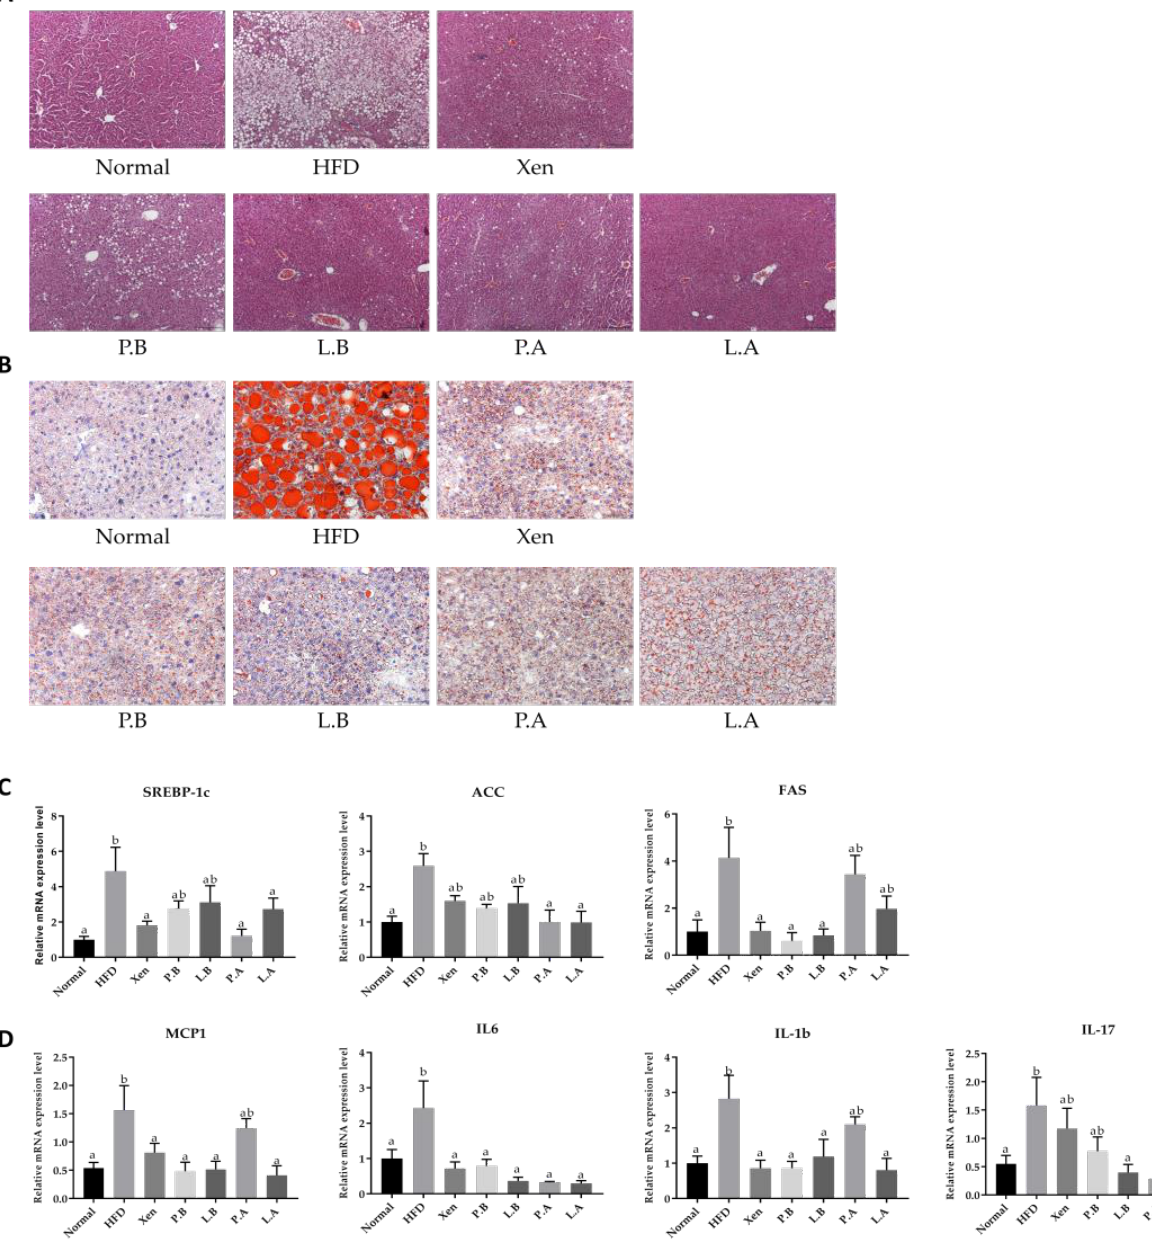
Figure 3. Oral administration of A. muciniphila strains suppressed steatosis, lipogenesis and inflammation in the liver of high-fat diet-induced mice. ( A ) Histological analysis of the H&E-stained liver tissue (scale bar, 100 µm). ( B ) Representative Oil Red O staining of the liver tissue to determine the hepatic fat deposition. (scale bar, 100 µm). ( C ) Hepatic gene expressions of lipogenesis markers SREBP-1c, ACC and FAS. ( D ) Hepatic gene expression of proinflammatory chemokine and cytokines. The data are expressed as means ± SD; the differences were statistically evaluated using one-way ANOVA. Means without a common letter significantly differ, p < 0.05. HFD, high-fat diet; Xen, orlistat, P.B, pasteurized BAA-835; L.B, live BAA-835; P.A, pasteurized A. muciniphila ; L.A, live A. muciniphila